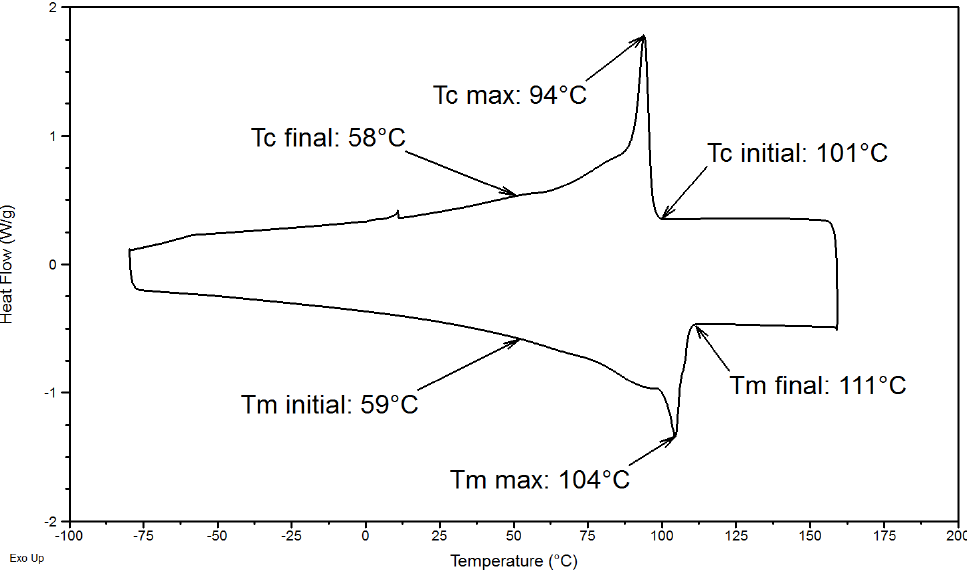
Figure 6. DSC curve of PE homopolymer during the heating (down) and the cooling (up) ramps. Melting and crystallization peaks are very wide, and the limits for peaks integration are therefore difficult to define. The degree of crystallinity X c of PE homopolymer was calculated using ∆ H m 0 , the melting enthalpy of 100% crystalline PE (285 J/g [22]) and ∆ H m , the melting enthalpy of the studied PE (126 J/g). The degree of crystallinity of this PE is equal to 44%.